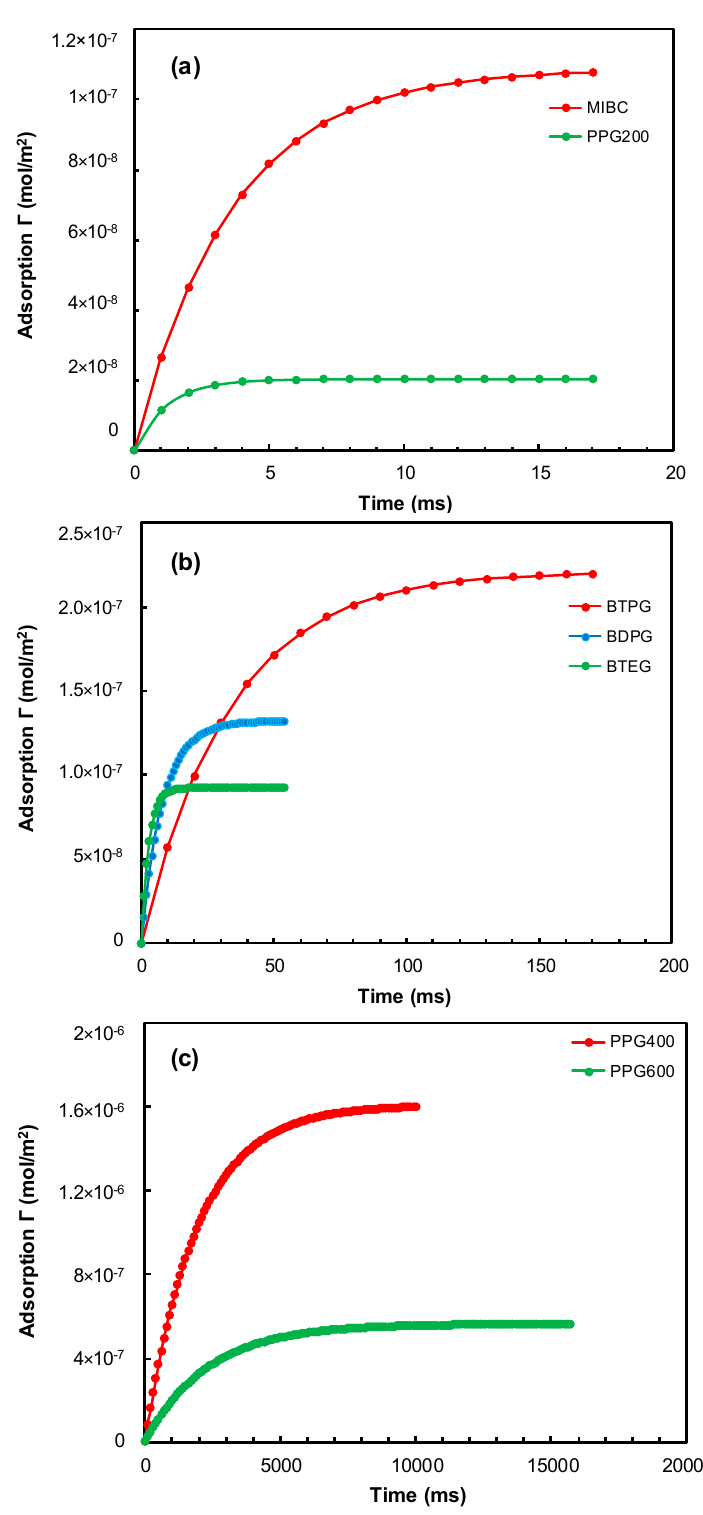
Figure 7. Adsorption of the frothers on the surface of rising bubbles versus time at CCC of ( a ) MIBC and PPG 200; ( b ) BTPG, BDPG, and BTEG; ( c ) PPG 400 and PPG 600.